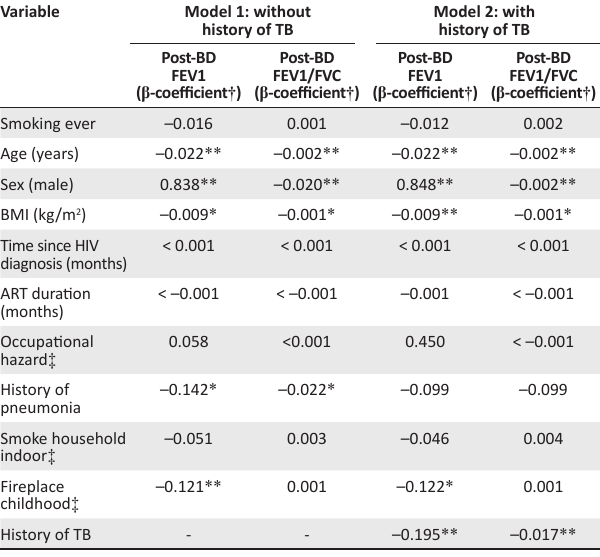
TABLE 2: Results of multivariable analysis for post-bronchodilator (BD) forced expiratory volume in 1 second and forced expiratory volume in 1 second/forced vital capacity on HIV-positive